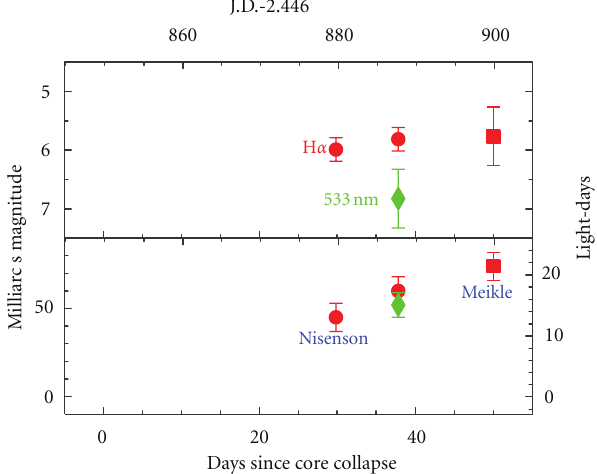
Figure 1: Measurements of displacement (lower) and observed magnitude (upper) of the “Mystery Spot” from SN 1987A, at H α and 533 nm, versus time, from